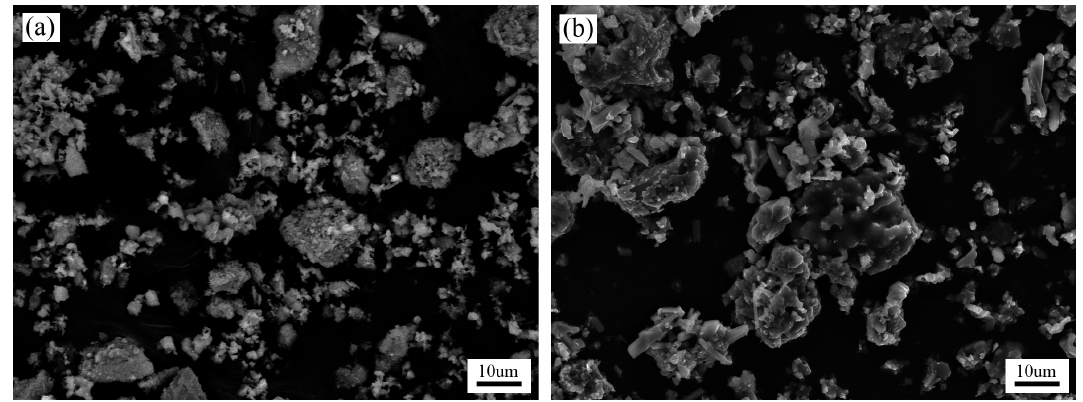
Figure 5. SEM photos of the samples roasted in 850 °C ( a ) and 950 °C ( b ).